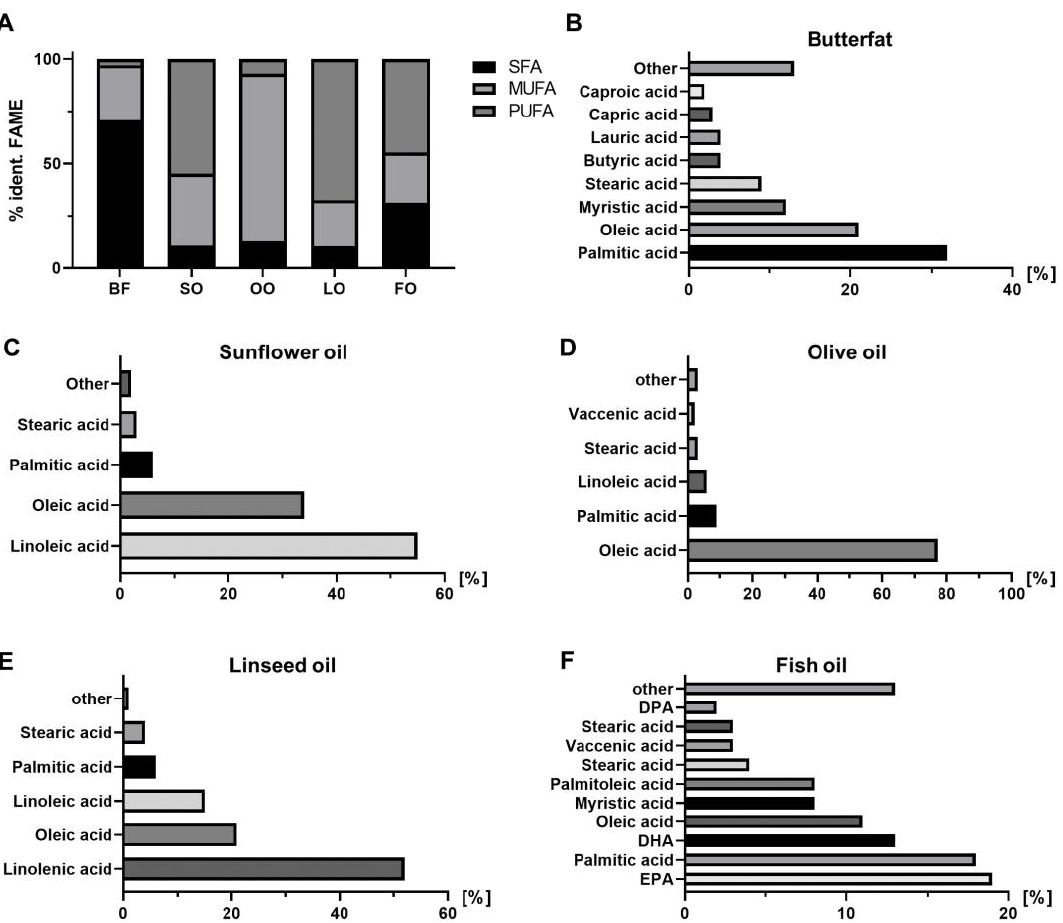
Figure 5. Fatty acid composition of the fats and oils used as supplements in the D. melanogaster feeding studies. ( A – F ) The fatty acid profiles of fats and oils were determined by capillary gas chromatography of fatty acid methyl esters (FAME) and data are calculated as % identified FAME. Butterfat (BF) predominantly consists of saturated fatty acids (SFAs), sunflower oil (SO), linseed oil (LO) and fish oil (FO) of polyunsaturated fatty acids (PUFAs) and olive oil (OO) of monounsaturated fatty acids (MUFAs).